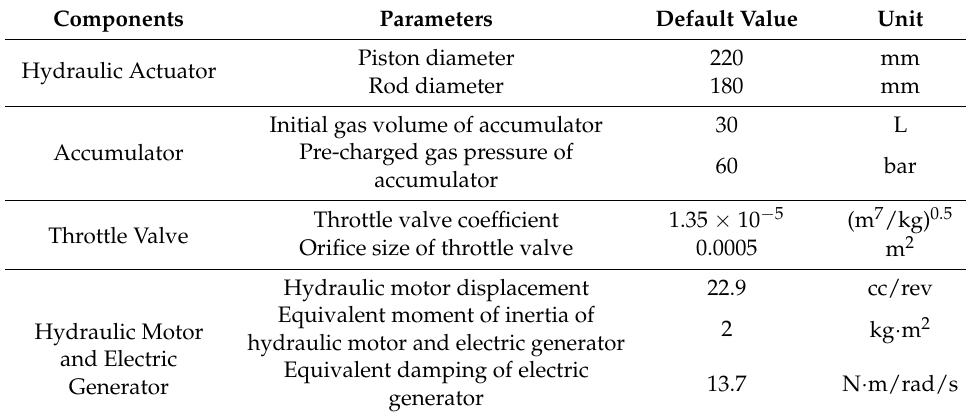
Table 3. Parameters of the hydraulic PTO system.